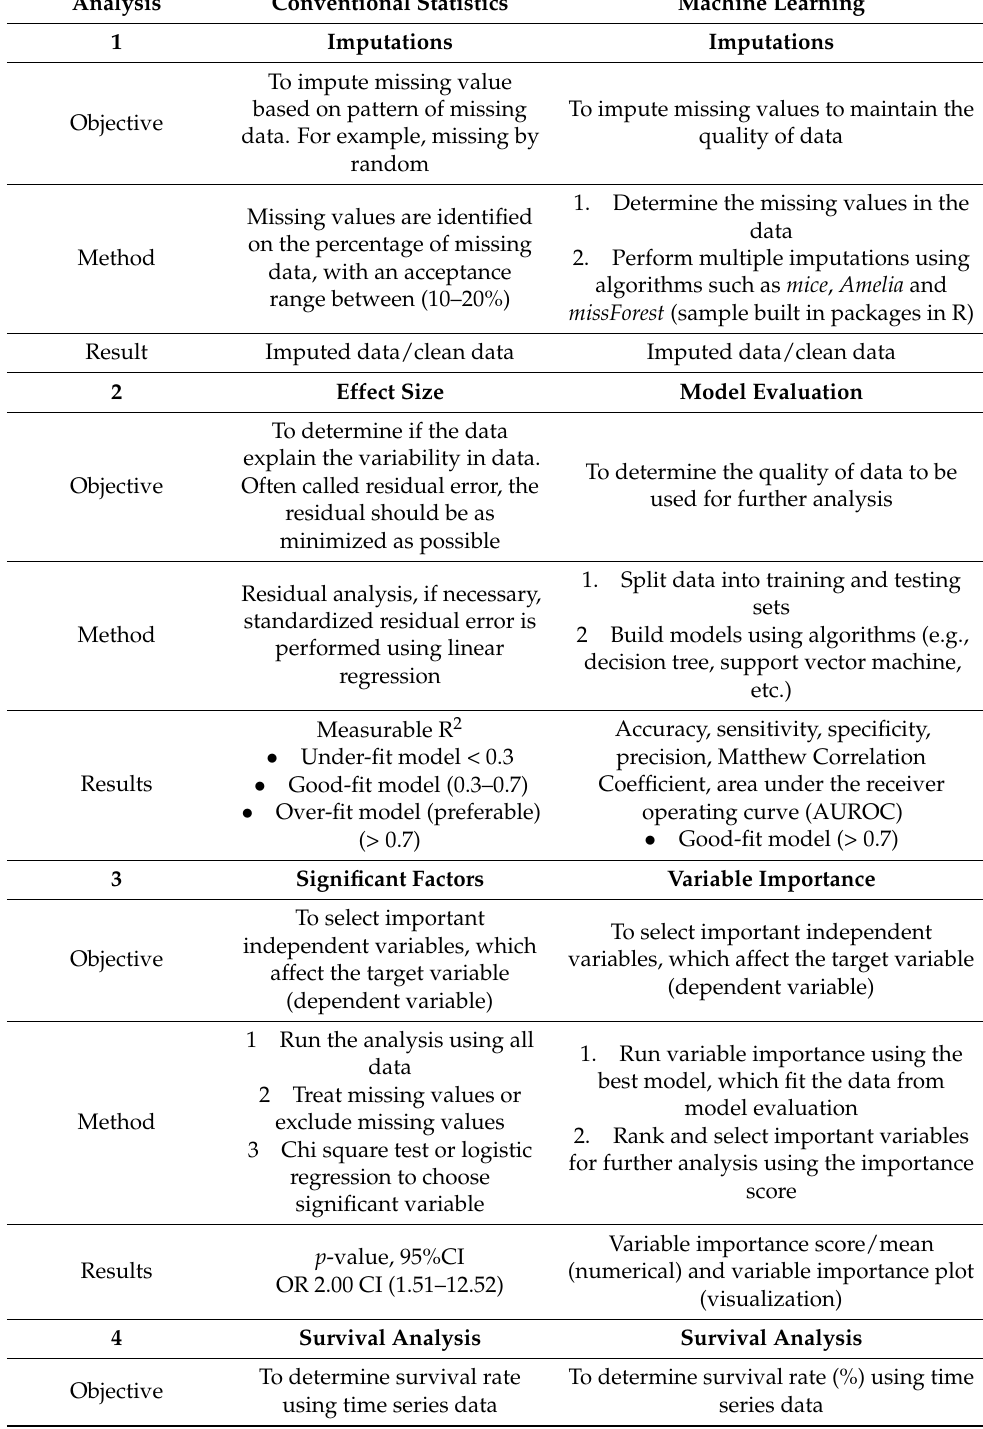
Table 3. Machine learning alternatives to conventional